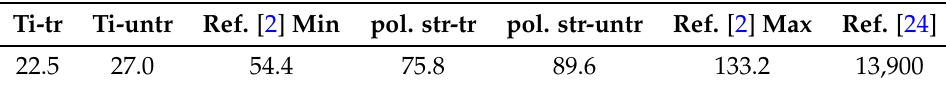
Table 4. Valley frequencies and hypothetical resonant frequencies (unit: kHz). tr: treated specimen; untr: untreated specimen; pol. str: polystyrene